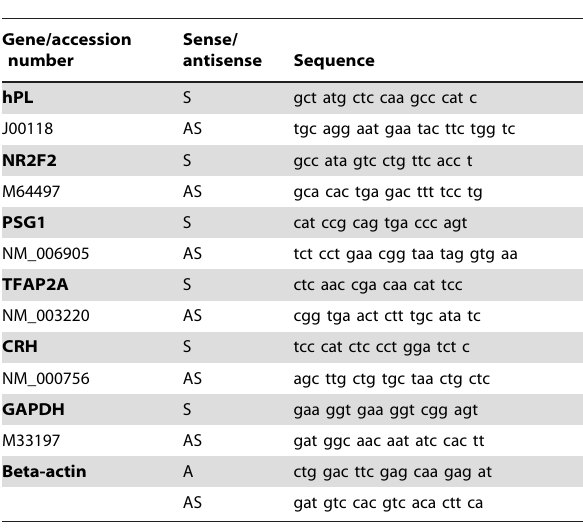
Table 1. Sequence of primers used in QPCR